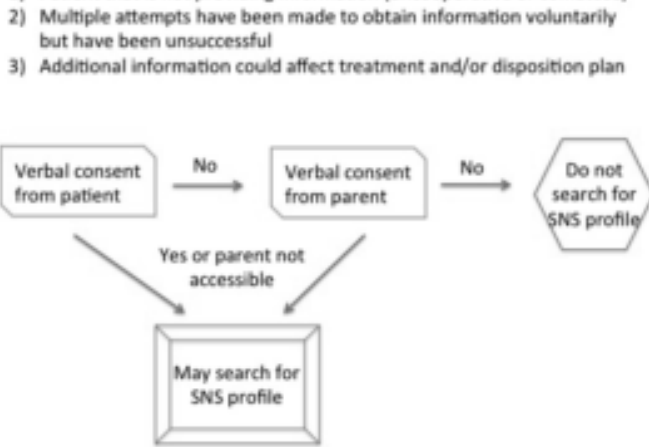
Figure 3. Guideline on when to access social network site (SNS)